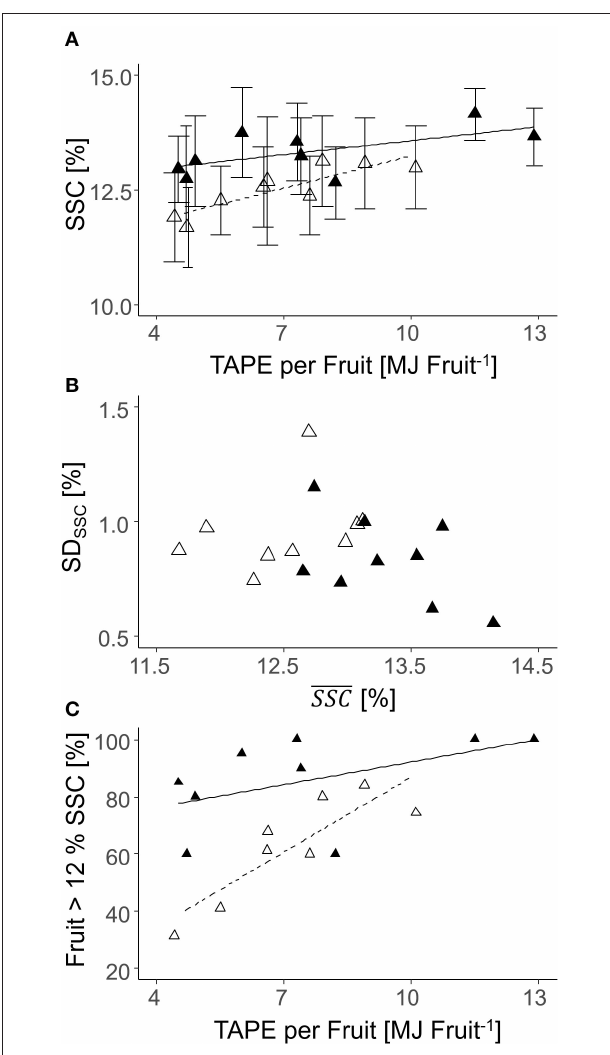
FIGURE 12 | Relationship between the total yield per tree and TAPE* (MJ) (A) ; the percentage of the marketable fruit with D > 65mm and TAPE per fruit (MJ fruit − 1 ) (B) of ‘Gala’ in 2018 [closed triangle, solid line, (A) R ² = 0.40; (B) R ² = 0.25] and 2019 [open triangle, dashed line, (A) R ² = 0.63; (B) R ² = 0.58] (2018: 80–127 DAFB; 2019: 84–138